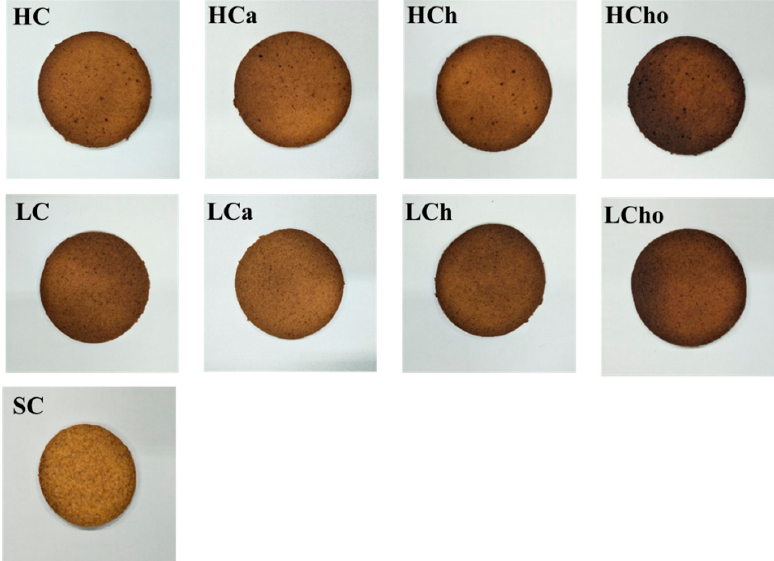
Figure 4. Effect of calcium carbonate, chitosan, and chitooligosaccharide on appearance in brown sugar cookies. SC: Sucrose cookie; HC: High acrylamide level of brown sugar in cookie; HCa: HC + calcium carbonate; HCh: HC + chitosan; HCho: HC + chitooligosaccharide; LC: Low acrylamide level of brown sugar in cookie; LCa: LC + calcium carbonate; LCh: LC + chitosan; LCho: LC + chitooligosaccharide. Table 2. Effect of calcium carbonate, chitosan, and chitooligosaccharide on the color values in brown sugar cookies. L